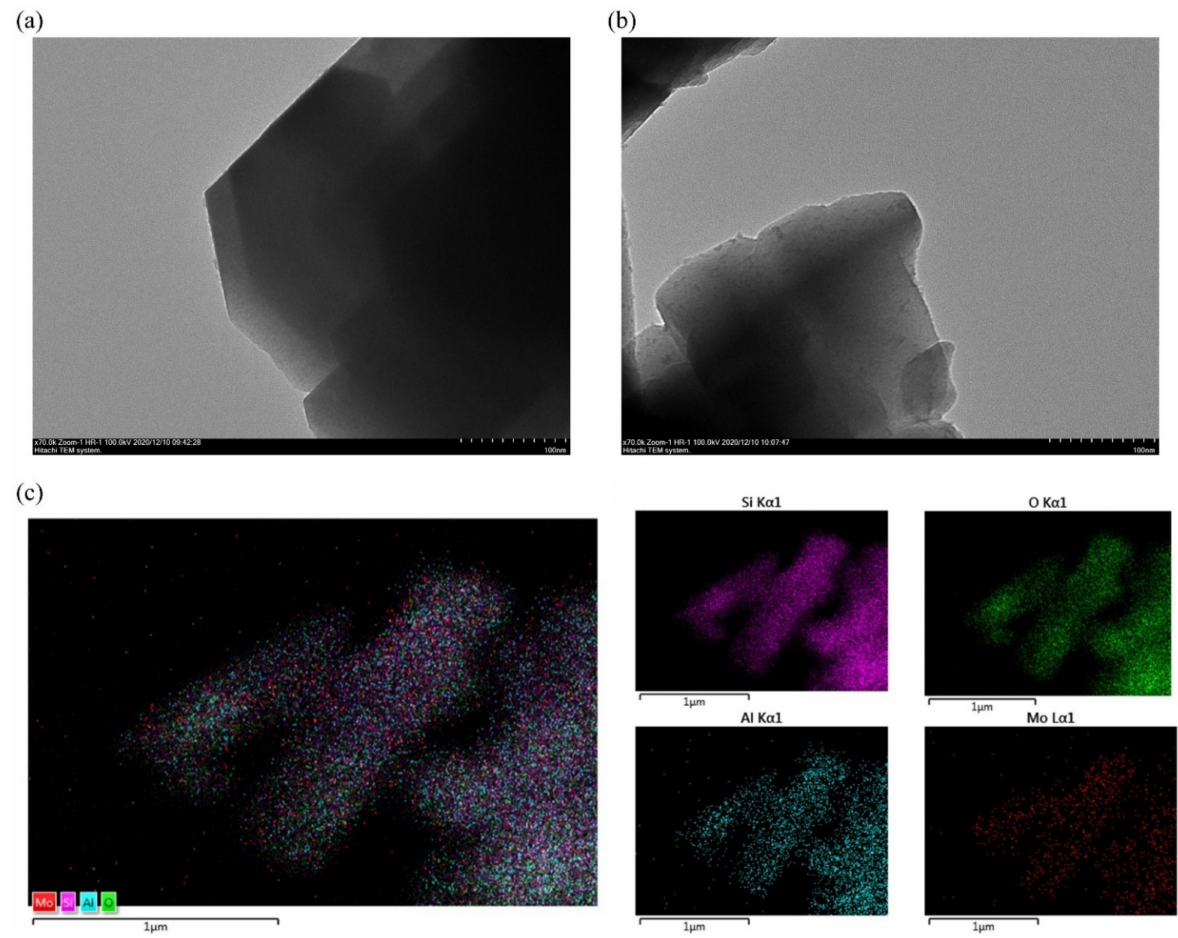
Figure 2. The results of TEM and STEM-EDS for HZSM-5 and Mo/HZSM-5. ( a ) TEM of HZSM-5, ( b ) TEM of Mo/HZSM-5, ( c ) STEM-EDS of